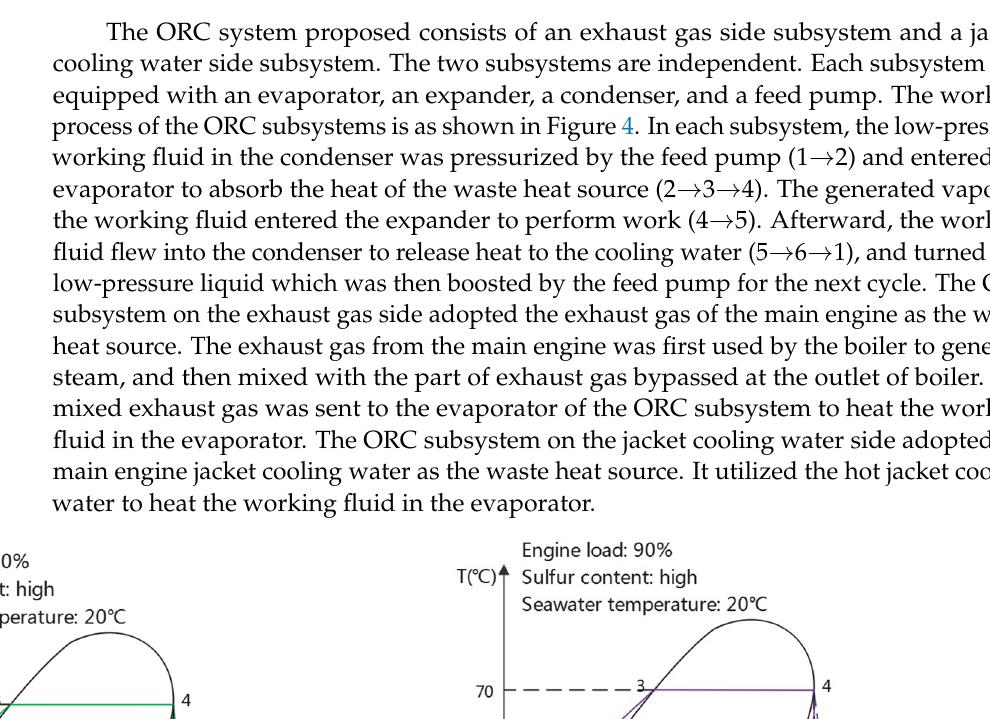
Figure 3. Schematic diagram of the ORC system.